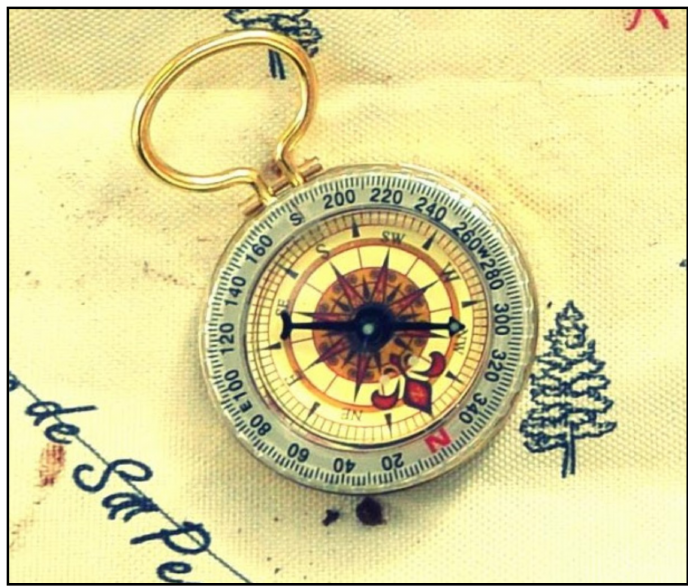
Figure 3. Compass with an indication of the north direction. Source: the author. 3. Oriented Mythical Spaces and the Meb ê ng ô kre People Universe